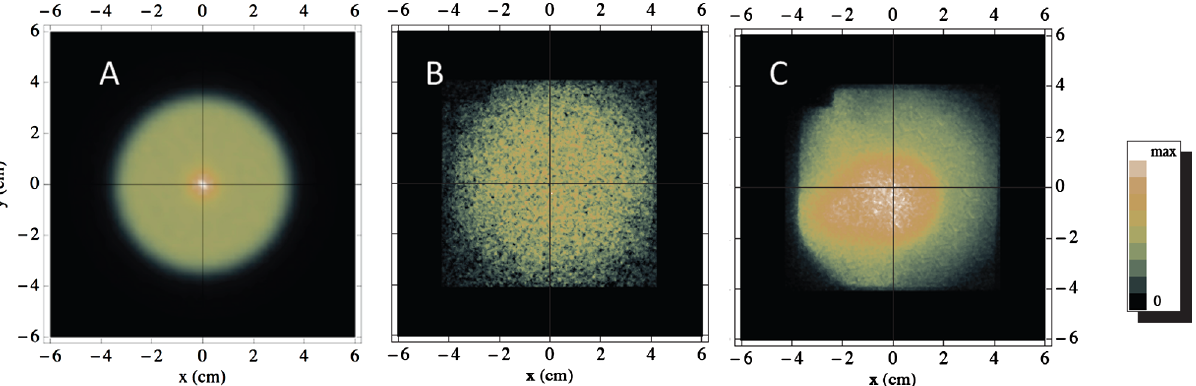
FIG. 8. (a) WARP simulations of the beam distribution at the scintillator plane, at z ¼ 90 cm . (b) Beam profile measured with the alumina scintillator and image-intensified CCD camera for V the beginning of the beam pulse. (c) Same as (b) except V